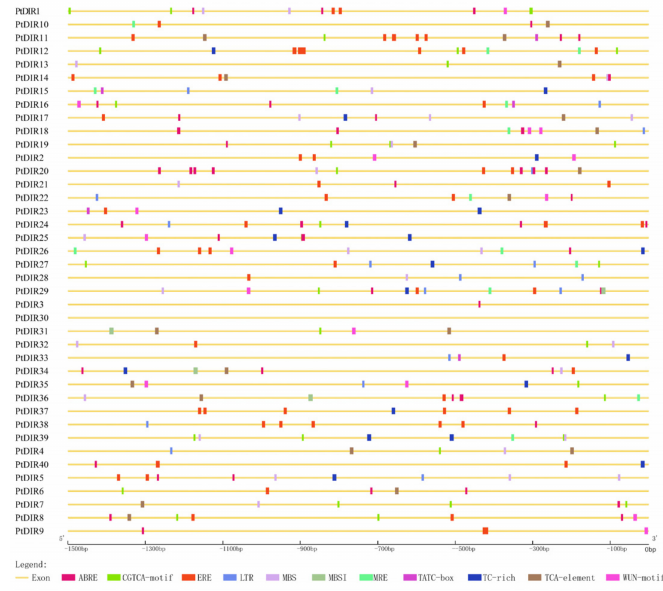
Figure 5. Predicted cis -elements in PtDIR promoters. Promoter sequences ( − 1500 bp) of 40 PtDIRs were analyzed by